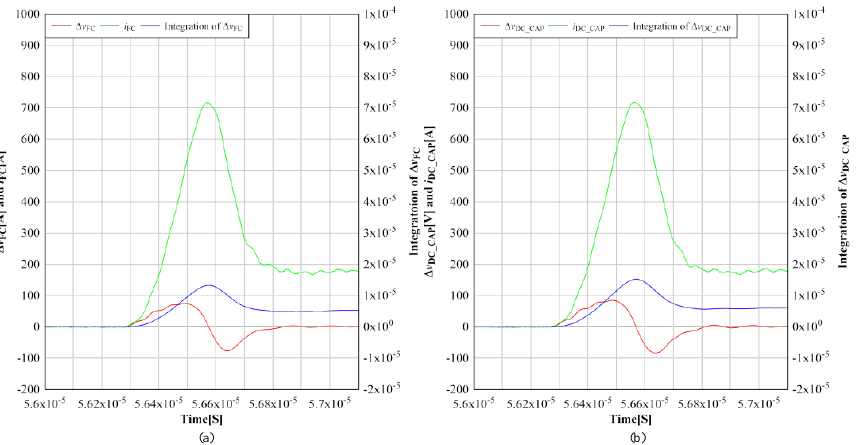
Figure 14. Stray inductance measurements of the DC-link capacitor and flying capacitor. ( a ) The flying capacitor test waveforms. ( b ) The DC-link capacitor test waveforms.